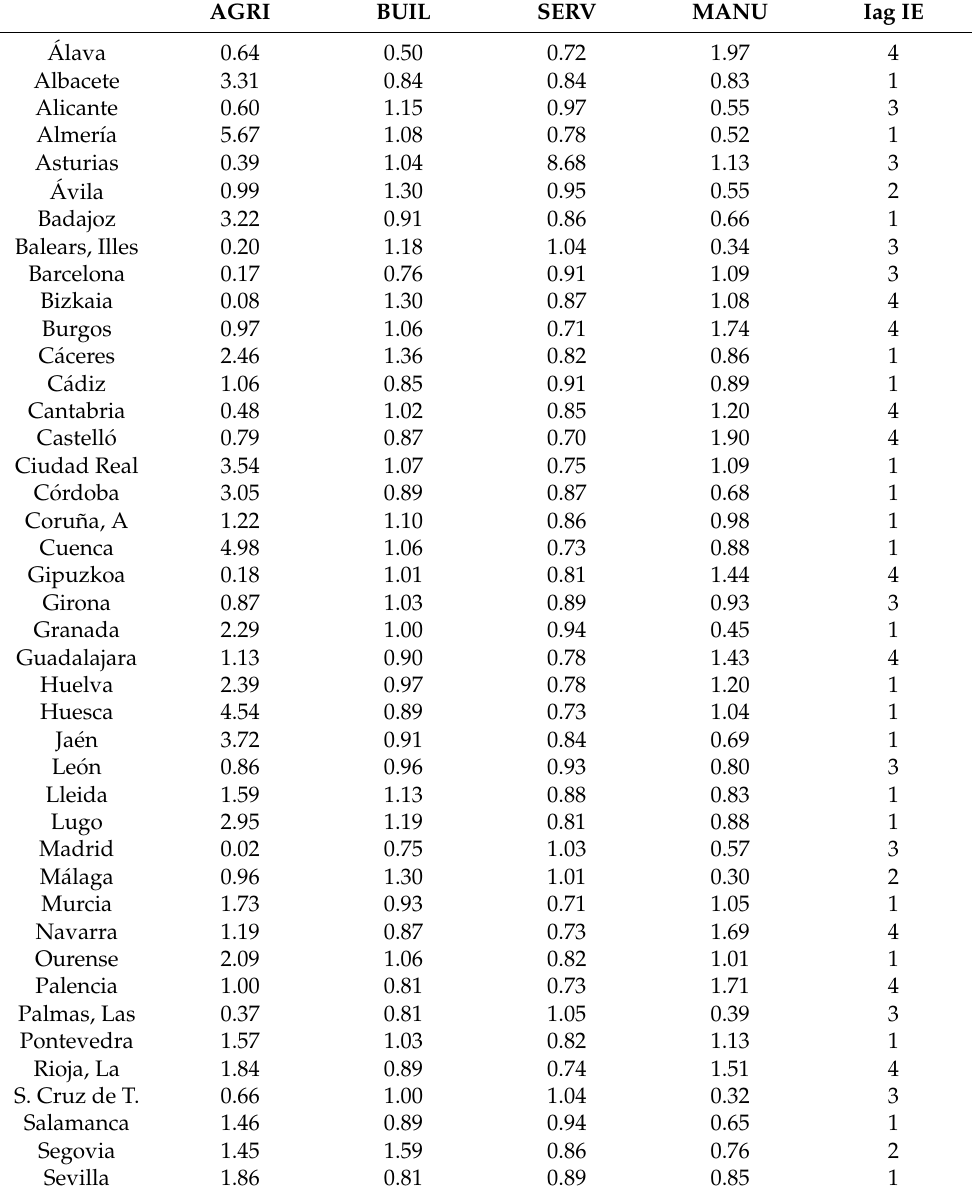
Table 1. Specialization indexes by industry and province. AGRI